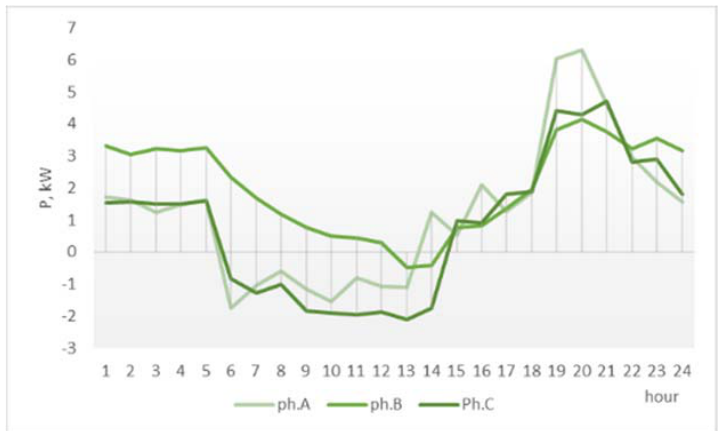
Figure 16. Actual bus demand in network R121 (aggregated demand and generation).